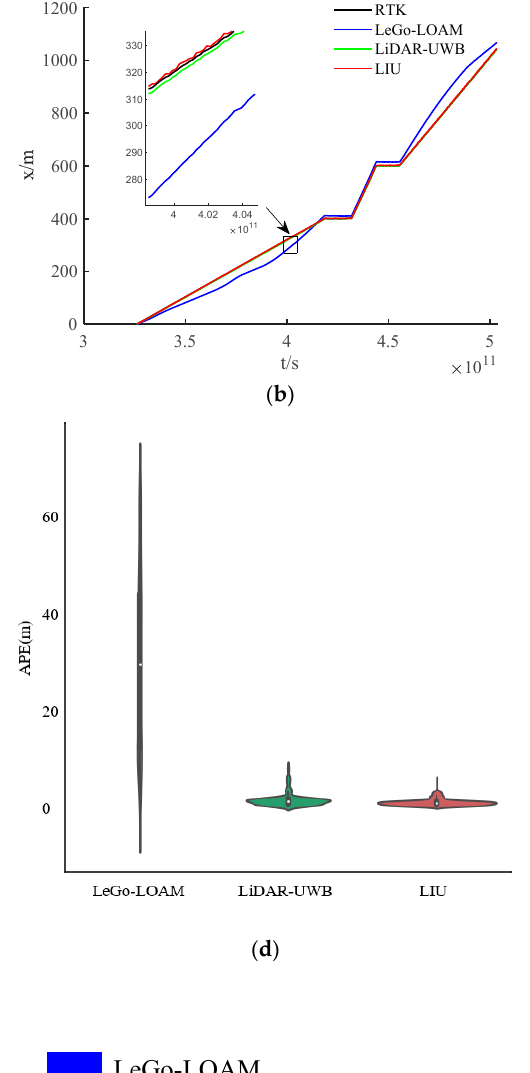
Figure 4. Experiment in a roadway with a length of about 85 m. ( a ) Trajectory curve; ( b ) position error along x-axis; ( c ) position error along y-axis; ( d ) APE violin histogram; ( e ) error value compar- ison.